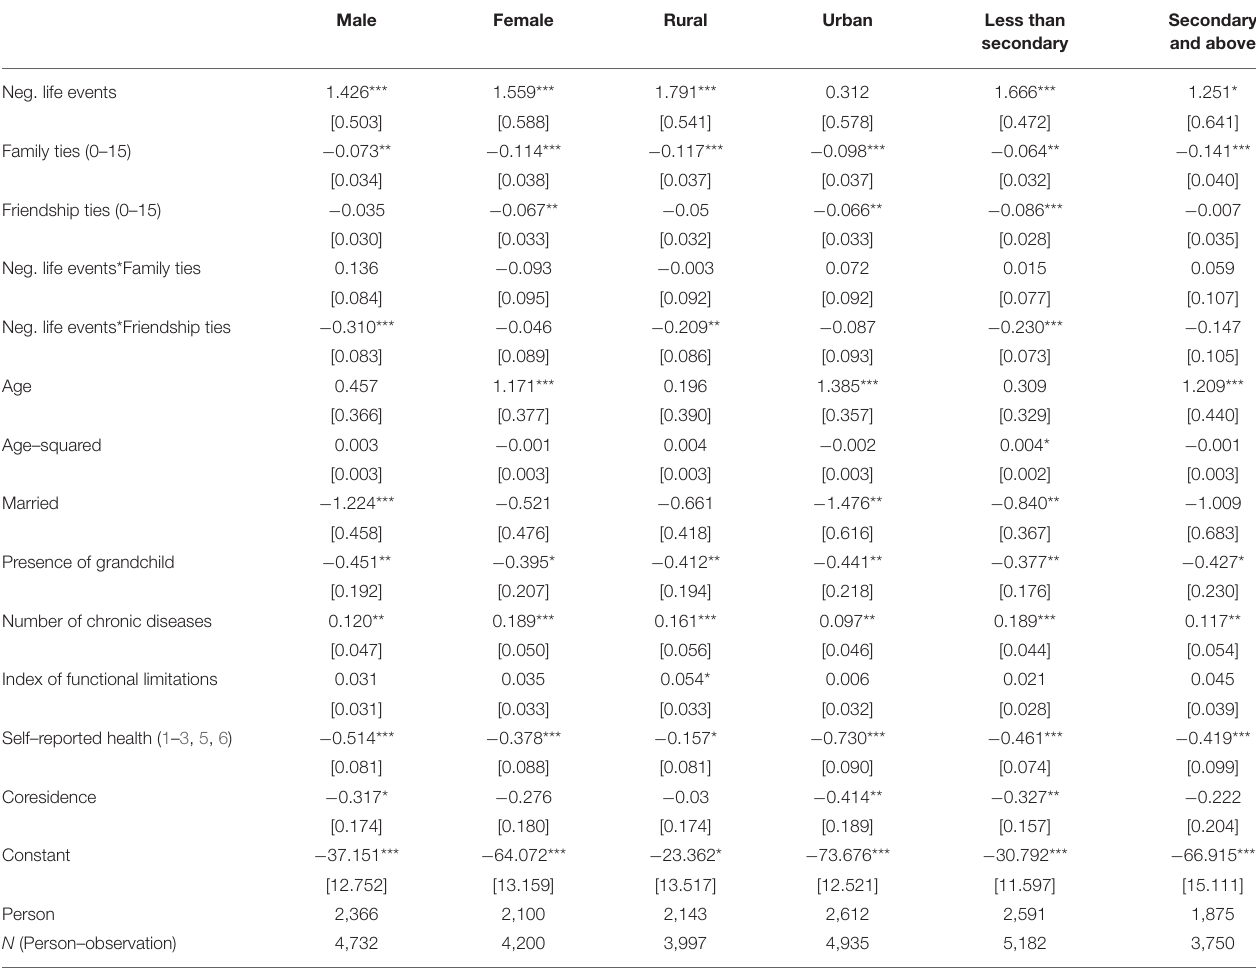
Secondary secondary and above